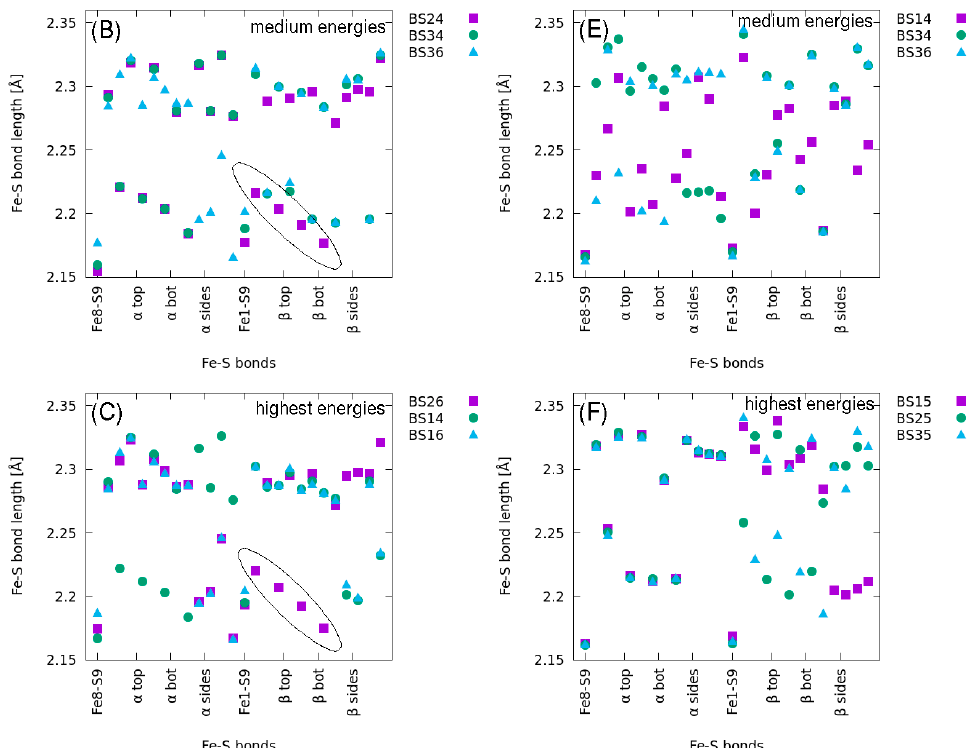
Figure 8. Fe–S bond lengths (Å) of low, medium, and highest energy BS states are compared for the DCC within ( A – C ) protein environment and ( D – F ) vacuum. The bond types are classified according to position within each cubane, Figure 8: Fe-S bond lengths (Å) of low, medium, and highest energy BS states “top” face, “bottom” face, “sides”. In general, the electrostatic protein environment induces more systematic Fe–S bonding are compared for the DCC within (A) protein environment and (B) vacuum. patterns, such as for the BS24, BS25, BS26 states (circled) in the B-cluster. Figure drawn using gnuplot and